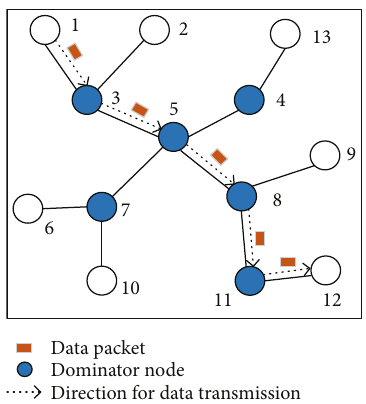
Figure 1: Network structure diagram.